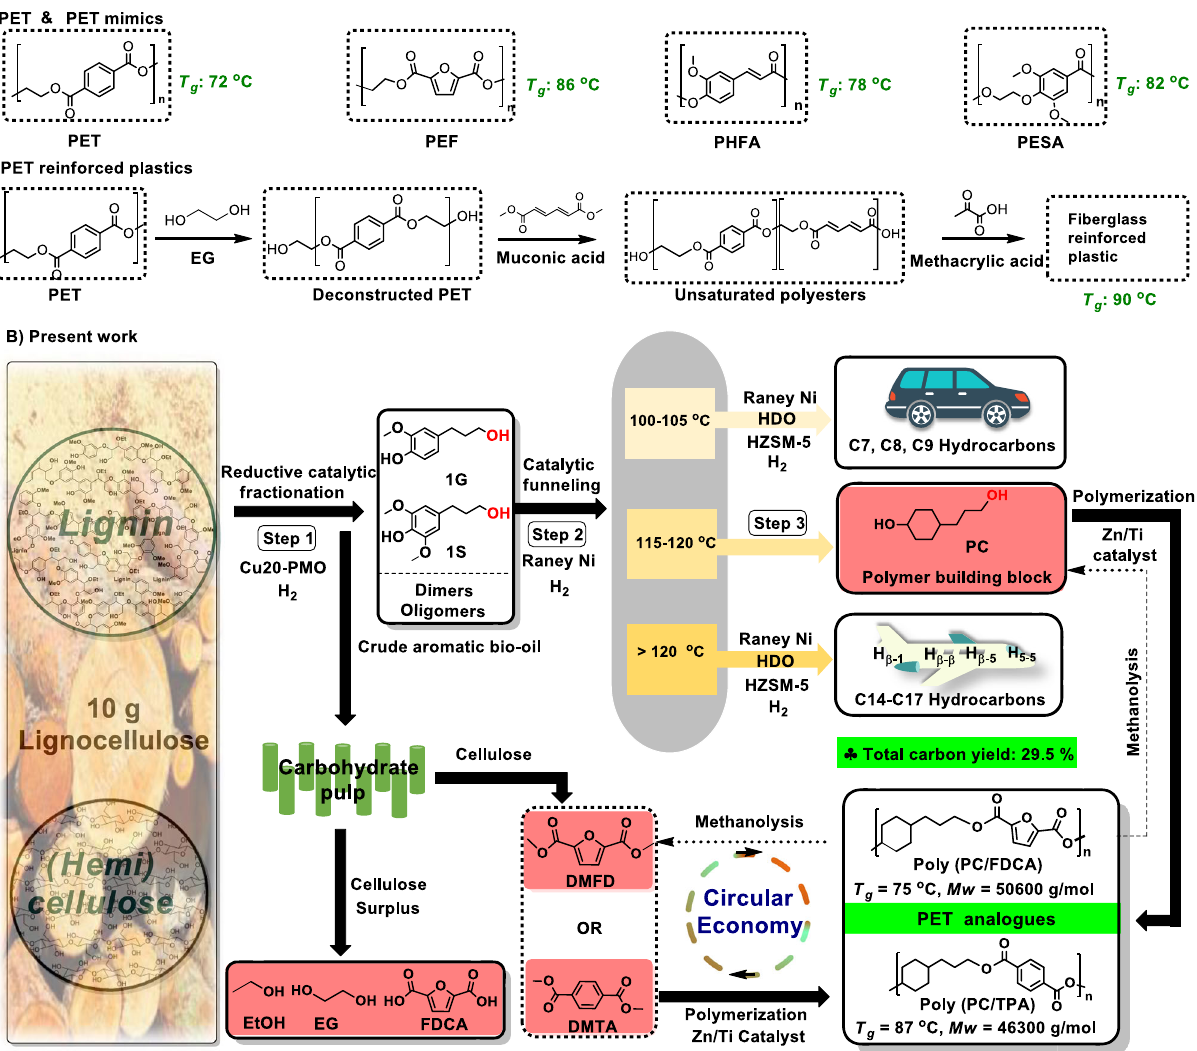
Fig. 1 An overview of bio-based PET analogues derived from lignocellulose. A Previous representative work to produce bio-based PET, PET mimics, and PET reinforced plastics. B Our comprehensive biore fi nery strategy to produce fully lignocellulose-based, recyclable PET analogs and other valuable products following three key steps: (1) Reductive catalytic fractionation (RCF) of lignocellulose over Cu20-PMO catalyst to give a crude lignin oil rich in 1 G and 1 S bearing a primary alcohol functionality; (2) Catalytic funneling of the ethyl-acetate extracted RCF mixtures to PC diol and other product streams using Raney Ni/isopropanol, (3) Copolymerization of PC with methyl esters of FDCA and TPA to give fully bio-based and recyclable polyesters poly (PC/ TPA) and poly (PC/FDCA). Potential valorization of the carbohydrate residues obtained upon RCF of the same lignocellulose source to the aromatic diacids FDCA and TPA is necessary for the copolymerization, while any surplus of cellulose can be converted to bioethanol and/or ethylene glycol (EG) (see Supplementary Note 1 for more